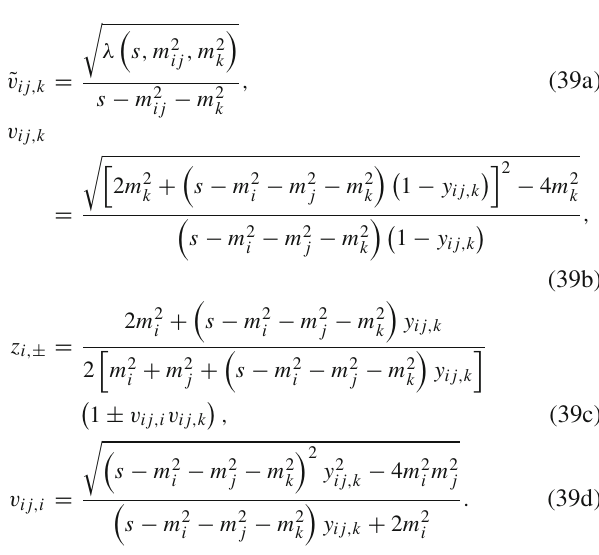
measure y 3 , defined as the value of the jet resolution